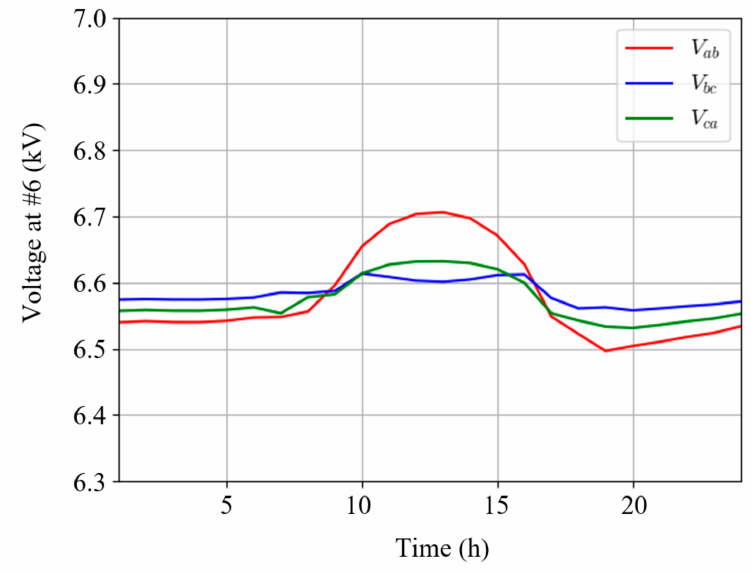
Figure 15. Time variation in voltage at #6 with single-phase